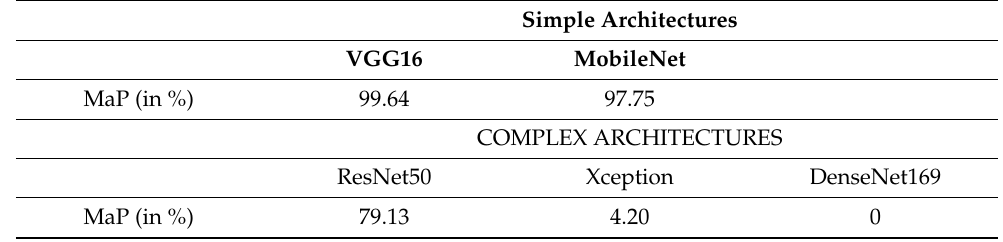
Table 4. MaP with RMAC layer after the last convolutional layer (in %).